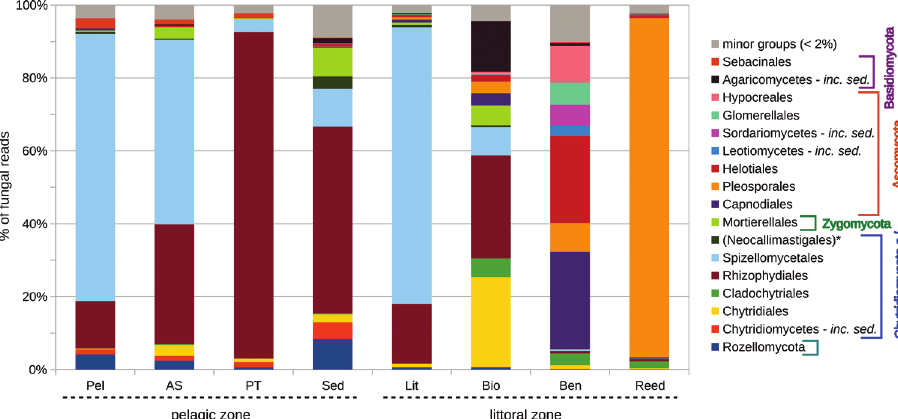
Figure 5. Distribution of fungal orders in Lake Stechlin habitats based on the mean percentages as determined with SILVA NGS. Fungal phyla are highlighted with brackets. Habitat codes are taken from Table 1. (*) marks the false classified Neocallimastigales as clarified by phylogenetic inference (see discus- sion paragraph on